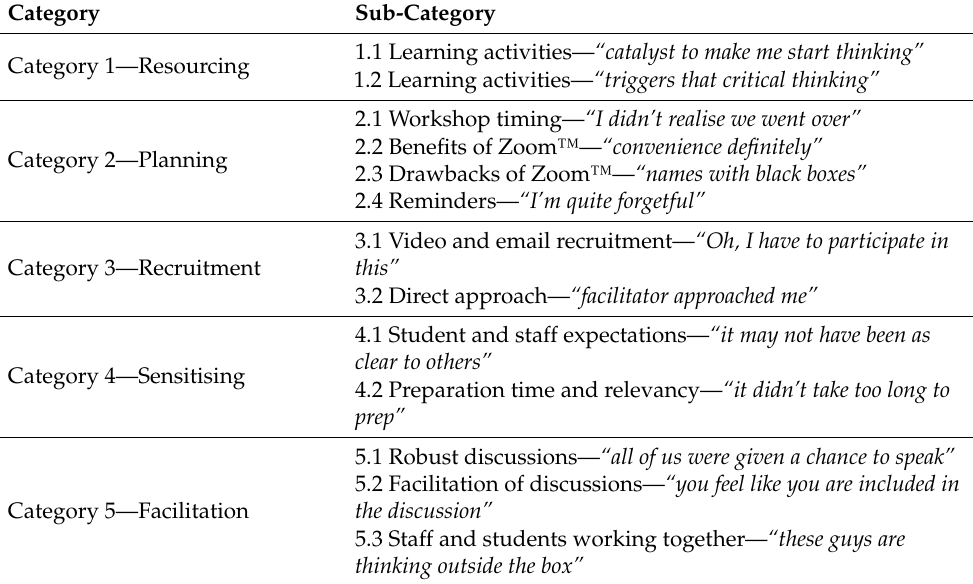
Table 2. Categories and